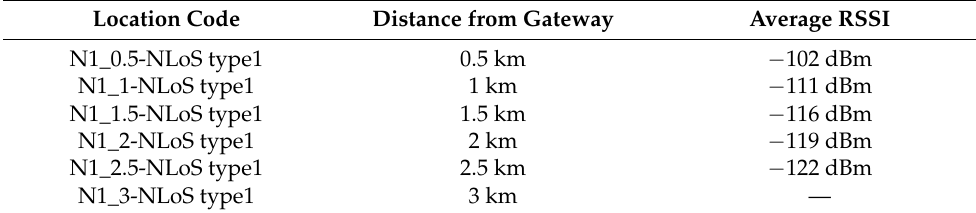
Table 5. RSSI average values obtained for partial blockage locations (NLoS1).